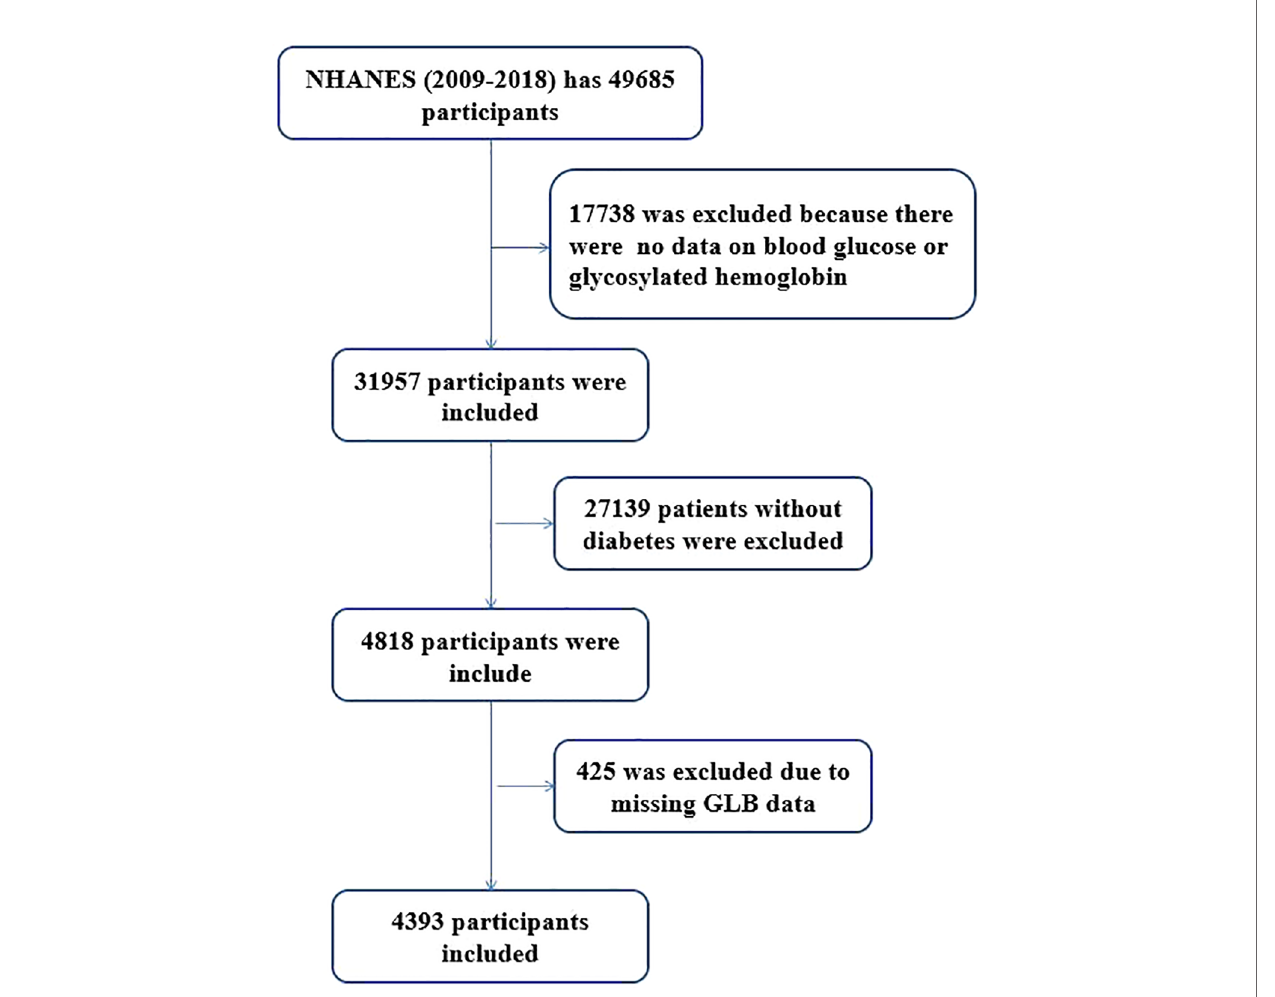
FIGURE 1 | Flowchart of participant